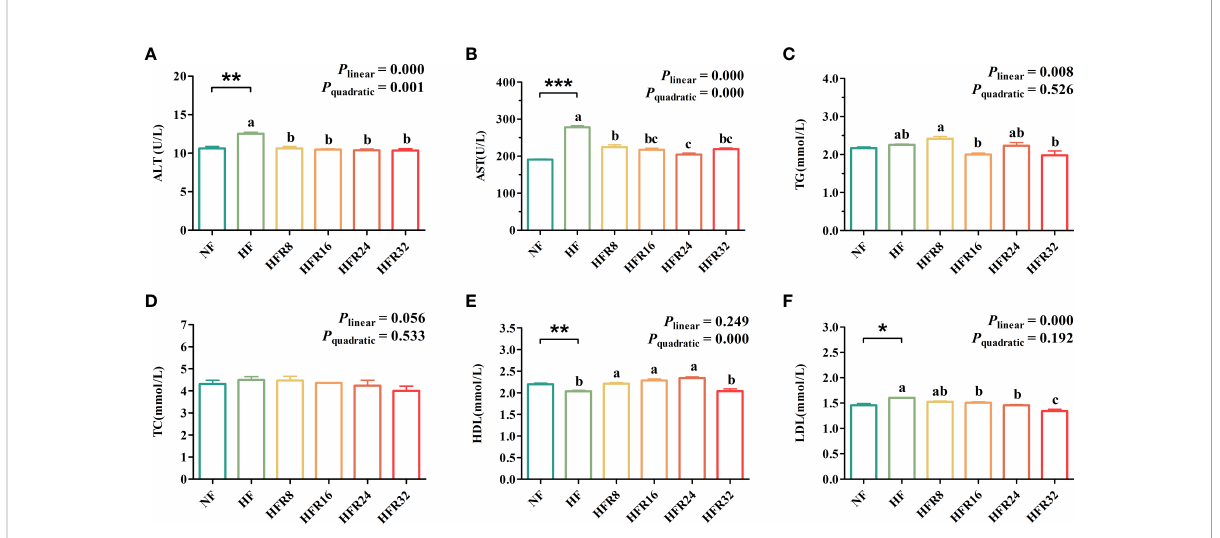
FIGURE 1 Effects of resveratrol supplementation on the hematological functions parameters in common carp (Cyprinus carpio ). (A) alanine aminotransferase (ALT) activity; (B) aspartate aminotransferase (AST) activity; (C) triglyceride (TG) concentration; (D) cholesterol (TC) concentration; (E) high-density lipoprotein (HDL) concentration; (F) low-density lipoprotein (LDL) concentration. Data are presented as means ± SEM. “ * ” represented statistical difference between the NF group and the HF group using student ’ s t -test (* P < 0.05, ** P < 0.01 or *** P < 0.001). “ abc ” represented statistical difference among different RSV levels in the HF diet. P -values indicated a linear and quadratic to dietary RSV levels using orthogonal polynomial analysis. Bars with different superscripts are statistically different ( P < 0.05, n =